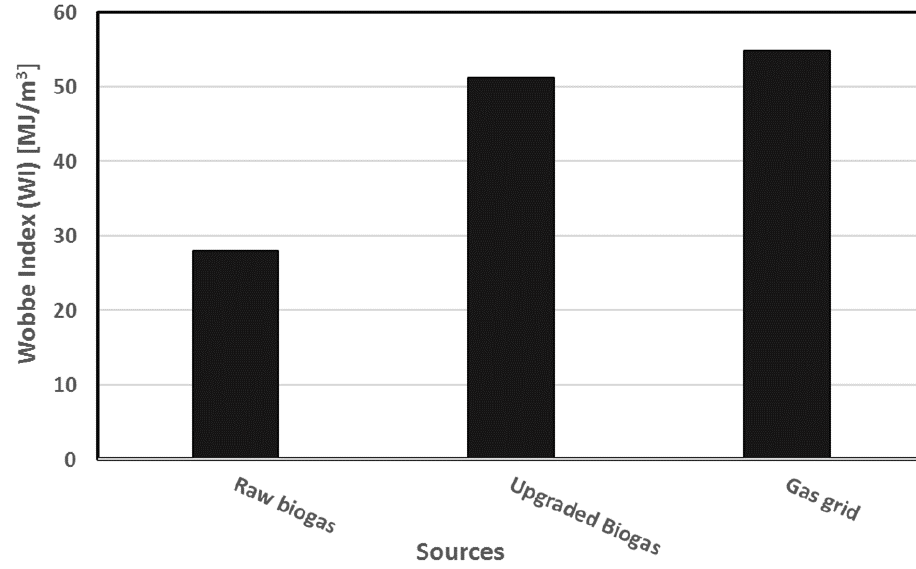
Figure 1. Wobbe index of different gases.